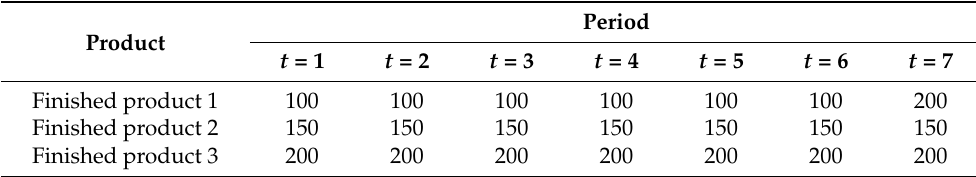
Table 5. Production demand in seven